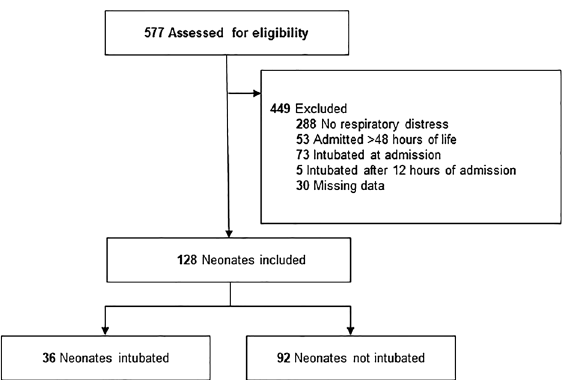
Figure 3. Flow chart for data